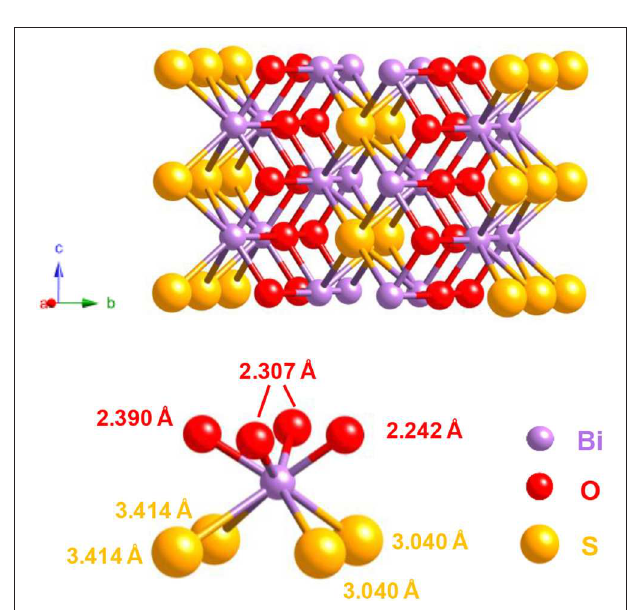
FIGURE 3 | Structure of Bi 2 O 2 S (JCPDS 10-2907) and bismuth coordination in the